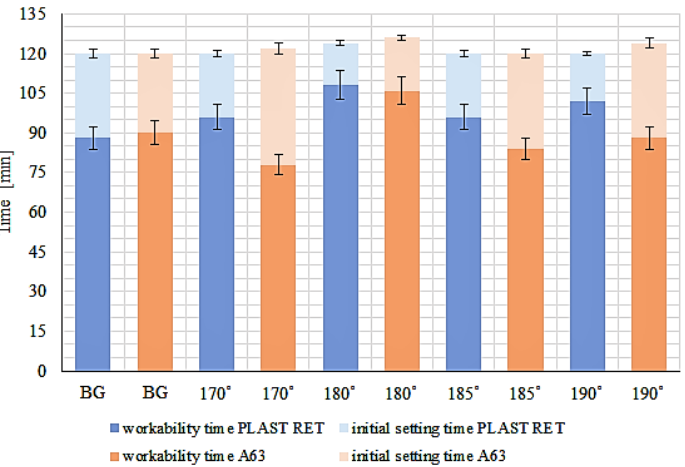
Figure 11. Relationships between the setting times and workability of masonry mortars modified with tartaric acid and Plast Ret as a function of the synthetic gypsum calcination temperature, which was calculated with an error bar value of 5%.